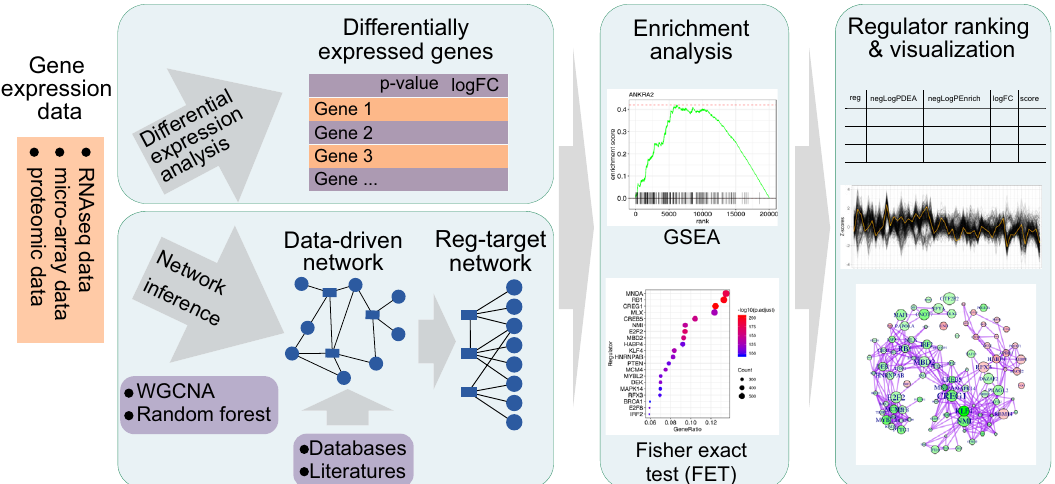
Fig. 1 The analytic work fl ow of RegEnrich package. RegEnrich consists of four major steps: differential expression analysis, regulator-target network construction, enrichment analysis, and regulator ranking and visualization.